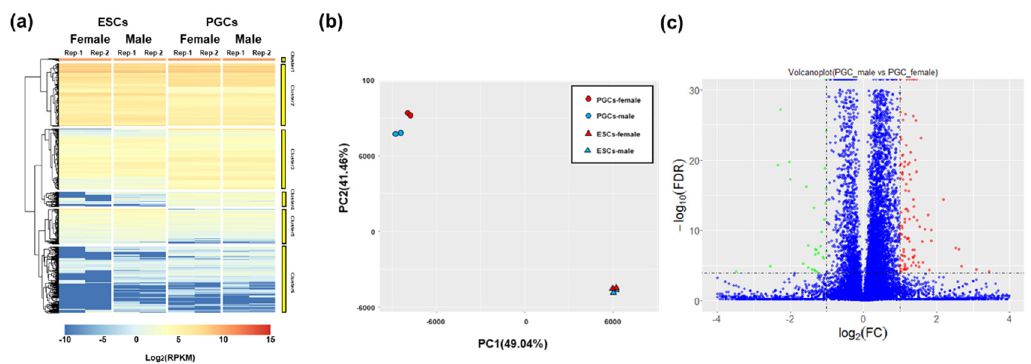
Figure 2. Transcriptome characterization of amphoteric ESCs and PGCs in chicken. ( a ) Heatmap showing differentially expressed genes (DEGs) in amphoteric ESCs and PGCs. Blue represents weakly expressed genes, and red represents highly expressed genes; ( b ) principal component analysis for eight samples. The first two principal components are displayed on the graph; ( c ) volcano plot where the x -axis represents the level of differential expression and the y -axis shows significant differences in expression as negative log values. The horizontal line is the threshold of corrected FDR < 0.001( − log10(FDR) > 3). In ovaries, downregulated genes are indicated by green dots, upregulated genes in ovaries are indicated by red dots, and other genes are indicated by blue dots.